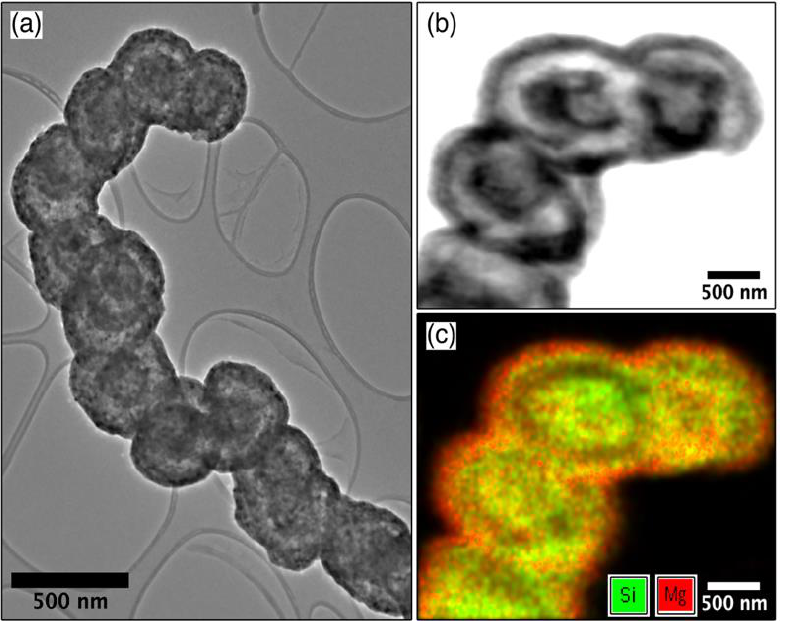
Figure 5. TEM micrographs of ( a ) a single Mg-coated NS coated in Mg. ( b ) A reference TEM micrograph of the end of the NS used for EDS mapping. ( c ). The corresponding EDS map of the end of the NS in ( b ), where red corresponds to Mg and green to Si.